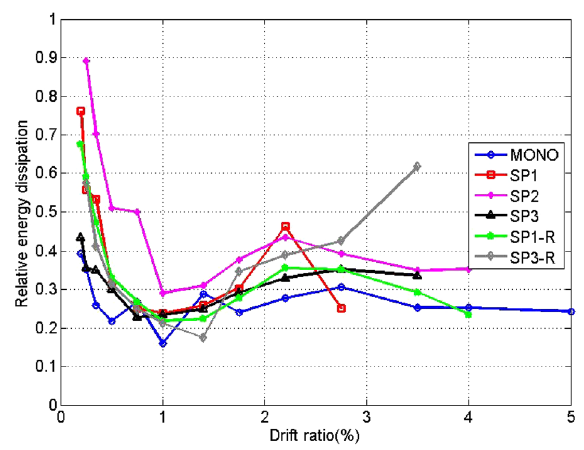
Fig. 24 Relative energy dissipation ratios ( b i ) of test